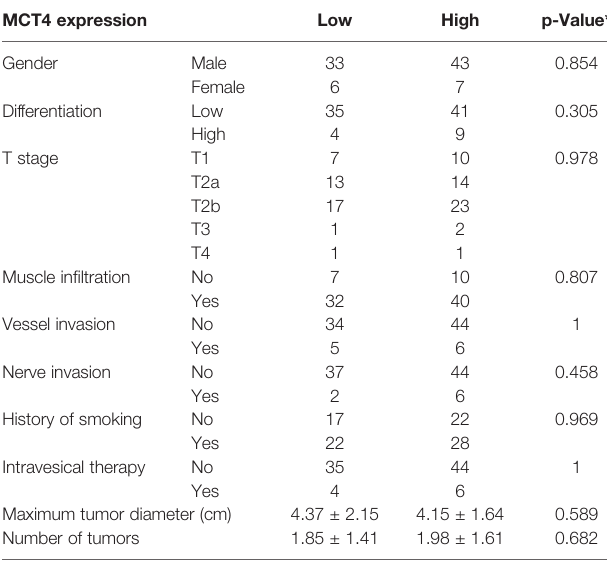
TABLE 2 | MCT4 expressions and clinical characteristics.